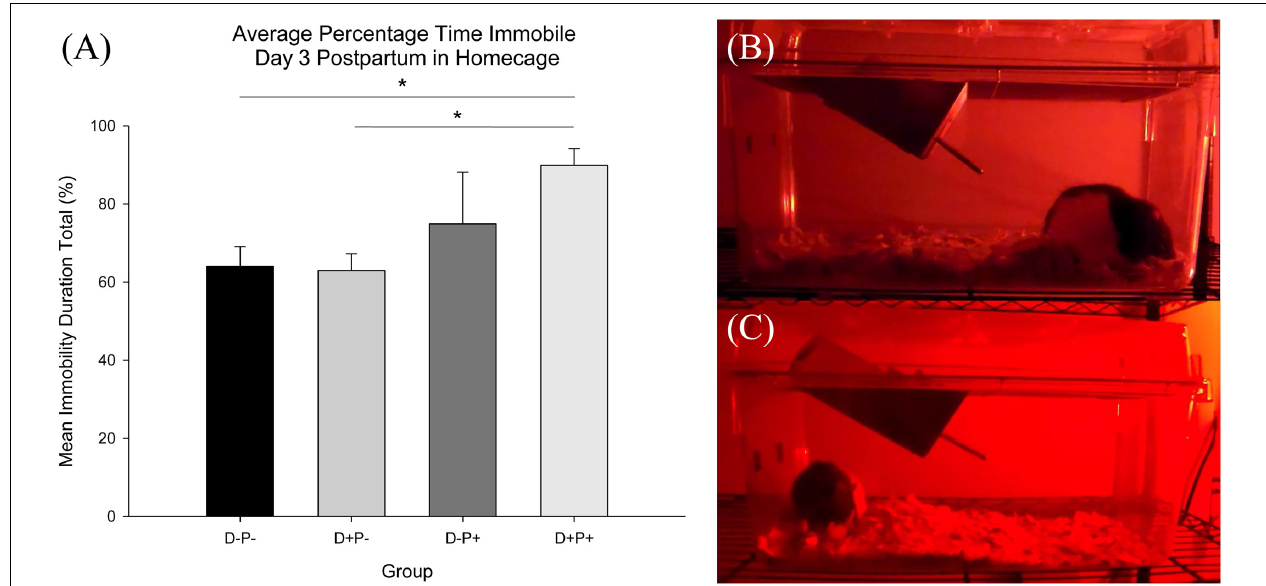
FIGURE 10 | (A) Average percentage time immobile in home-cage. Percentage immobility time was significantly reduced in the D+P+ group relative to D − P − and D+P − . ∗ p < 0.05. Data is expressed as mean ± SEM. (B,C) Freeze-frame shot of home-cage behavior recording during dark cycle day 3 postpartum. (B) D+P+; hunched posture typical of D+P+ group and (C) D − P+; mother nursing pups.